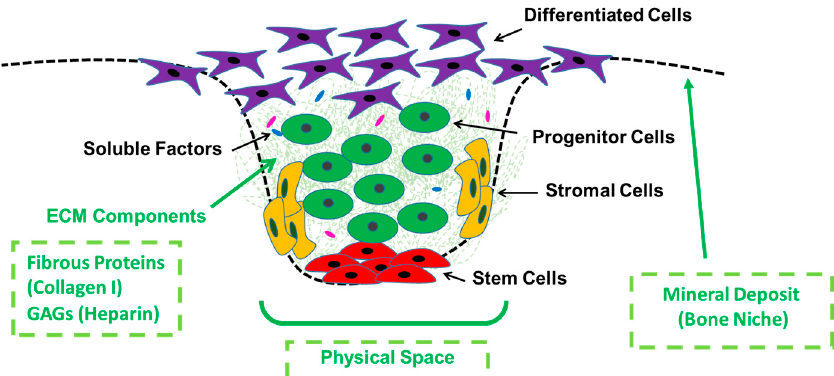
Figure 1. General schematic of a stem cell niche environment showing key characteristics, cell type locations, and highlighting (in green) the specific components we aimed to investigate in this work (manufacture of a physical and discrete space and biofunctionalization with extracellular matrix (ECM) and mineral components (Bioglass, BG)).